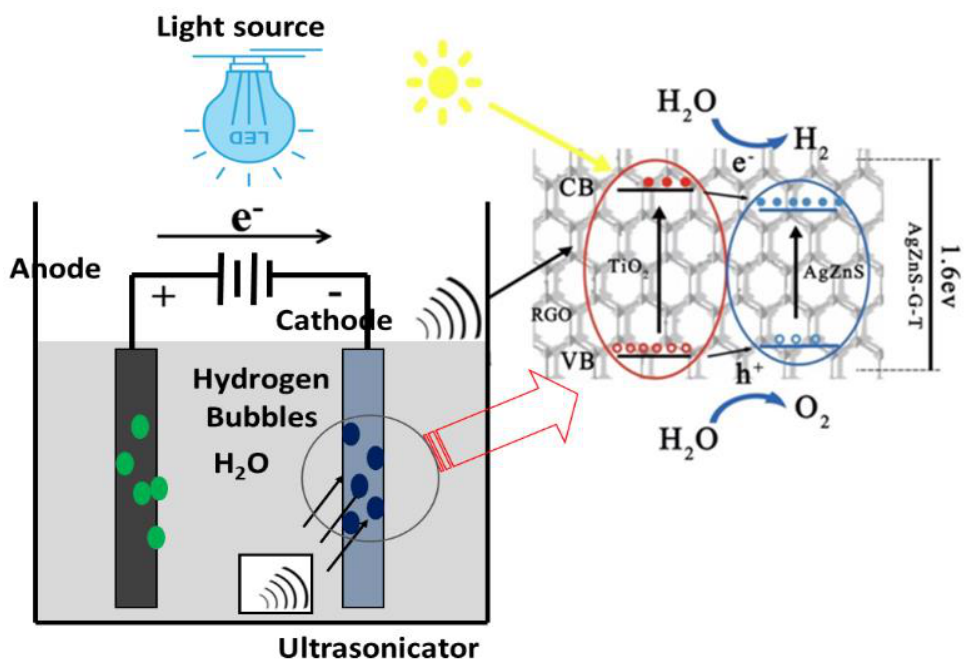
Figure 8. Electros onophotocatalytic reduction and its mechanism of H 2 evolution on the electrode sur- Figure 8. face.